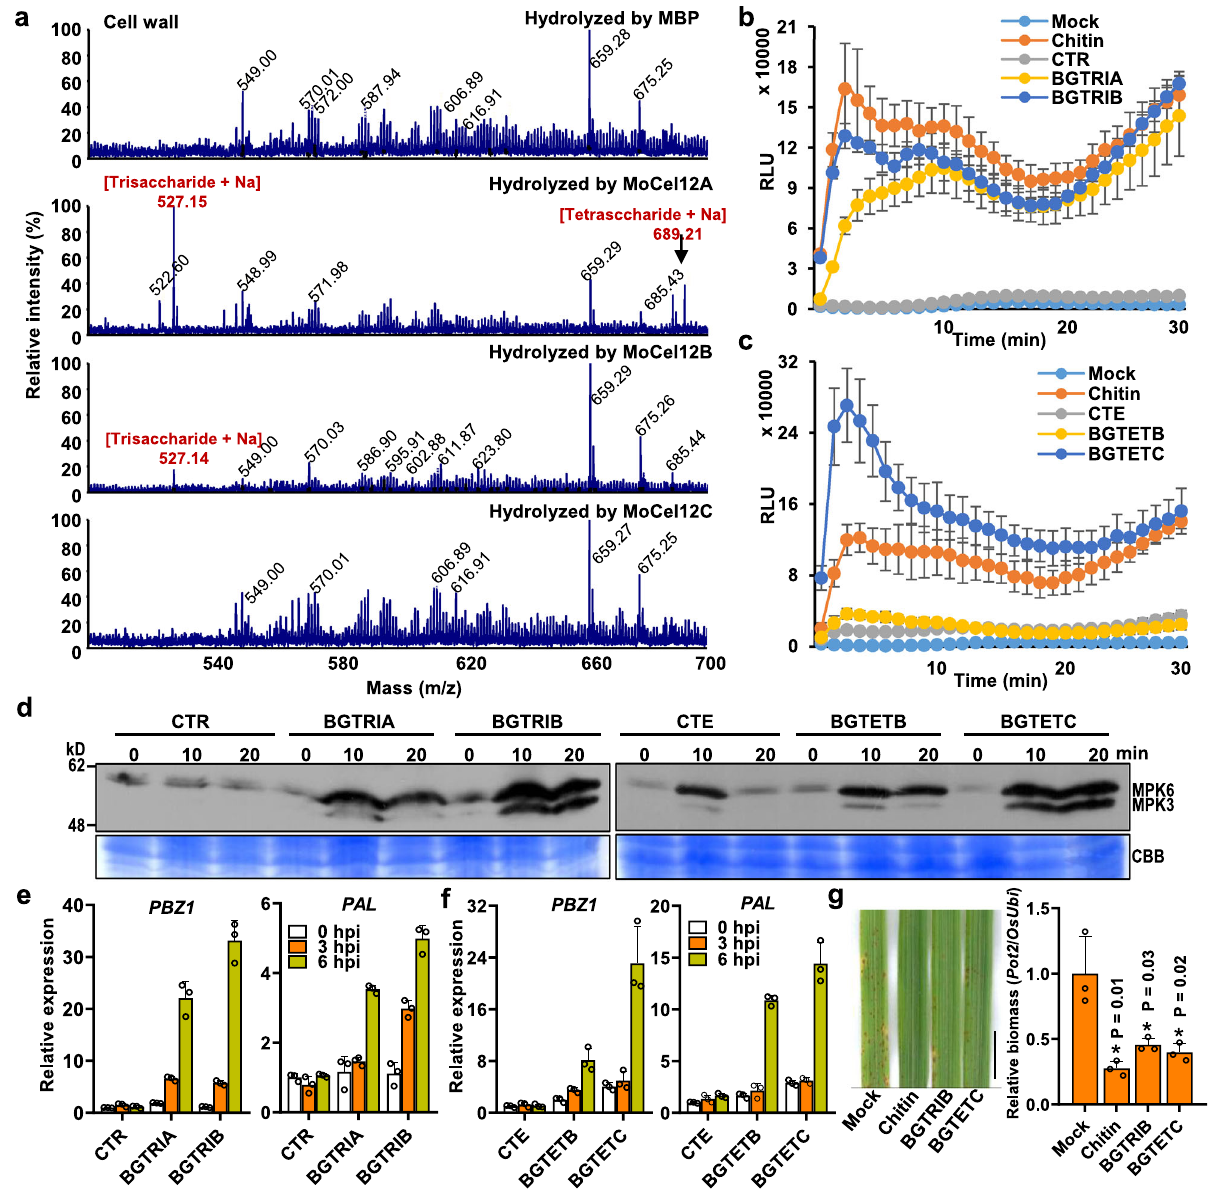
Fig. 4 The speci fi c trisaccharides and tetrasaccharides released by MoCel12A from rice cell wall activate the immune response in rice. a The oligosaccharides of MoCel12A, MoCel12B, and MoCel12C hydrolyzed cell wall detected by MALDI-TOF-MS. The fi ltered supernatants of MoCels- hydrolyzed rice cell walls were used for the analysis, using 10 mg/ml 2,5-dihydroxybenzoic acid in 2:1 acetonitrile:water as the matrix. All indicated peaks are single-charged ions of oligosaccharides on the reducing end with Na + using 3-aminoquinoline (3-AMQ) as ionic liquid matrix. b The trisaccharides activate ROS burst in rice-suspension cells. 10 μ M each of CTR (cellotriose, G4G4G), BGTRIA (3 2 - β - D -glucosyl-cellobiose, G3G4G), and BGTRIB (3 1 - β - D - cellobiosyl-glucose, G4G3G) were used for the ROS burst assays. Chitin (10 μ g/ml) served as the positive control. c The tetrasaccharides activate ROS burst in rice. CTE (cellotetraose, G4G4G4G), BGTETB (3 1 - β - D -cellotriosyl-glucose, G4G4G3G), and BGTETC (3 2 - β - D -cellobiosyl-cellobiose + 3 3 - β - D - glucosyl-cellotriose, G4G3G4G + G3G4G4G) were used for the ROS burst assays (10 μ M each). Others are as in ( b ). d The trisaccharides and tetrasaccharides activated MAP kinase cascades in rice. The rice-suspension cells were treated with oligosaccharides (10 μ M) and were used for MAPK activation assays. e , f The trisaccharides and tetrasaccharides induced PTI marker gene expression. Treatments with oligosaccharides and rice-suspension cells were same as in ( d ), and the samples were collected for RT-qPCR at the indicated time points. Values are means ± SD ( n = 3 biological replicates). g Pretreatment with BGTRIB and BGTETC enhanced the blast disease resistance in rice. Two-week-old rice plants were treated with 50 μ g/ml chitin, 100 μ M BGTRIB and BGTETC for 3 h, then the leaves were spray-inoculated with conidial suspensions (1 × 10 5 conidia per ml in 0.02% Tween-20) for 4 d. Bar = 1 cm. The right panel is the relative fungal biomass. Values are means ± SD ( n = 3 biological replicates). * indicates signi fi cant differences from the Mock at P < 0.05 (two-sided Student ’ s t